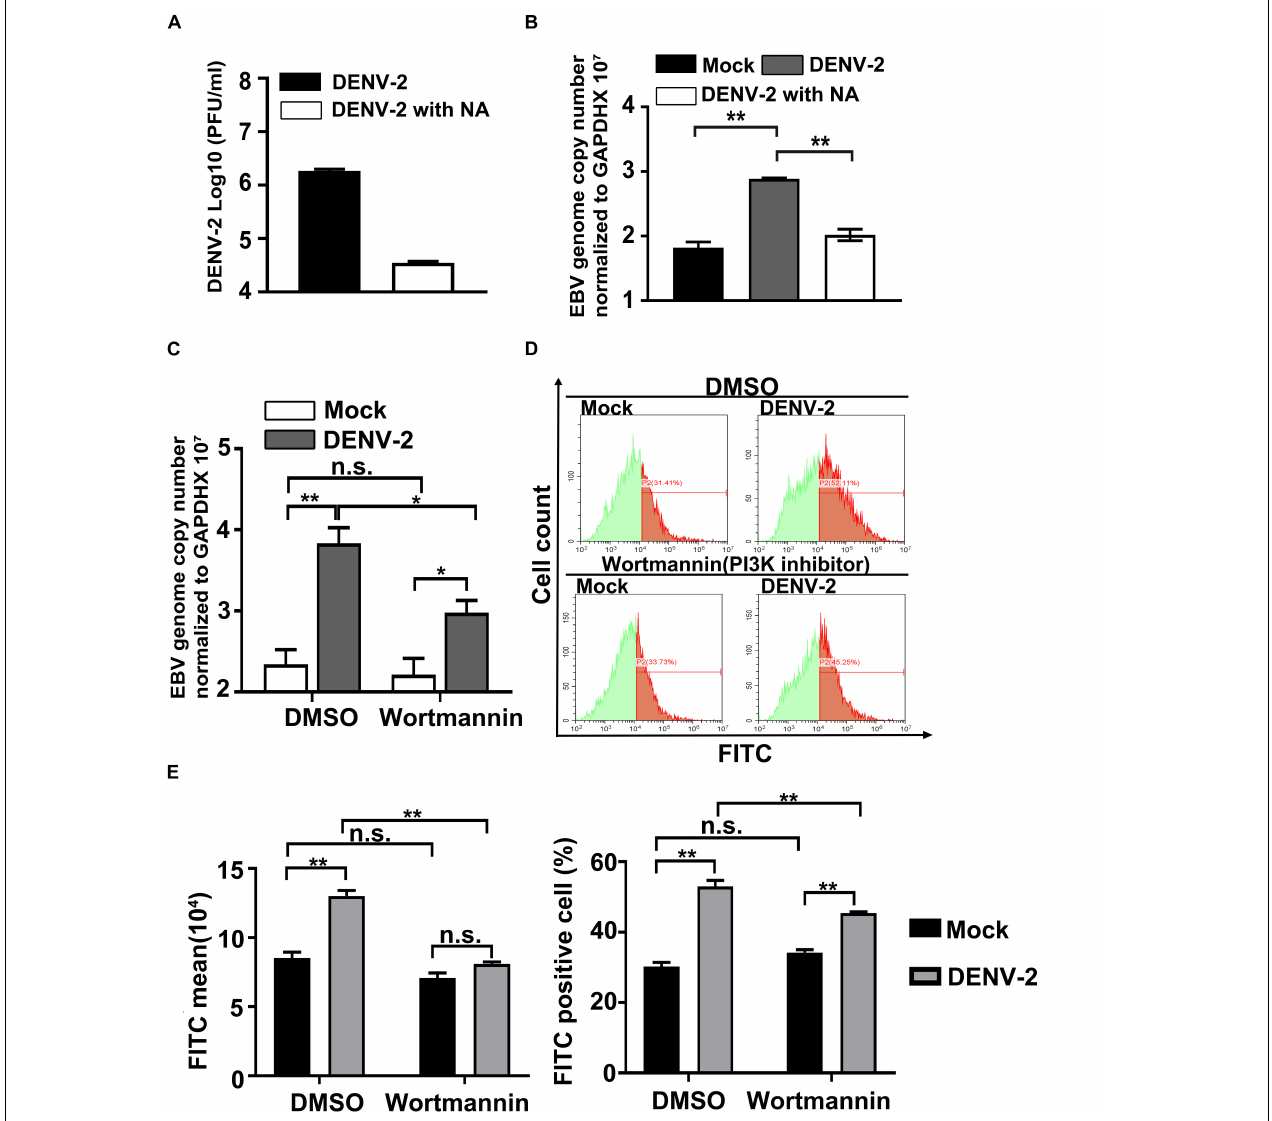
FIGURE 2 | Wortmannin treatment blocks DENV-2 infection-induced Epstein–Barr virus (EBV) reactivation. (A) A neutralizing antibody (NA) was mixed with the DENV-2 virus to neutralize infectious viral particles (DENV-2 with NA). The neutralization effect was confirmed by plaque assay. (B) EBV + Akata cells were mock-infected or infected with non-neutralized (DENV-2) or neutralized DENV-2 (DENV-2 with NA). At 72 hpi, relative EBV genome load was quantified. (C,D) Mock- or DENV-2-infected EBV + Akata cells were treated with DMSO or 0.2 µ M wortmannin. At 72 hpi, relative EBV genome load was determined (C) . Green fluorescent protein (GFP) intensity of the four experimental groups was quantified by flow cytometry. The representative result of three independent experiments was shown in panel D , and quantification and statistical analysis of mean GFP value and percentage of GFP-positive cells were shown in panel E . p < 0.01 was marked as ** and p < 0.05 was marked as